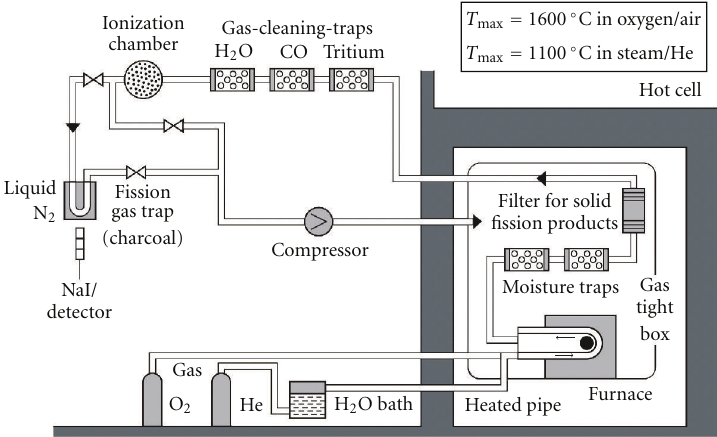
Figure 9: Schema of KORA facility for examination of HTR fuel in oxidizing gases.